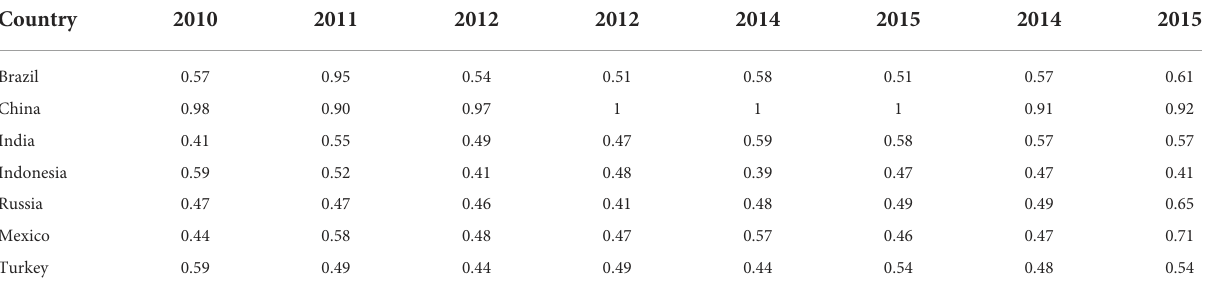
FIGURE1 Green economic performance index.